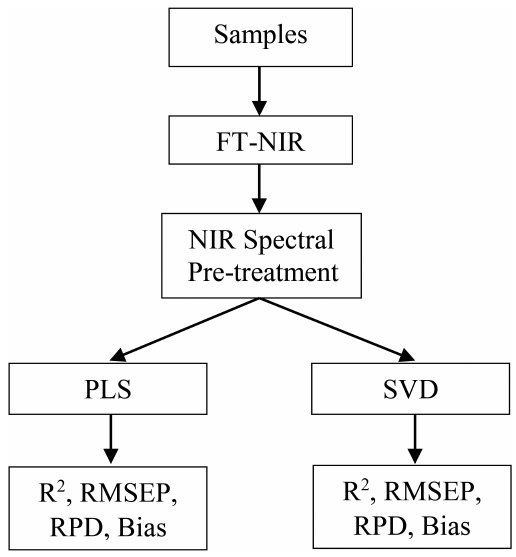
Fig. 1. Flow diagram of the